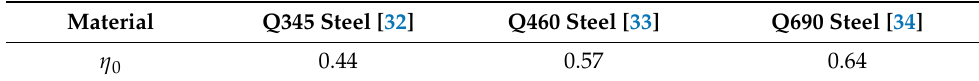
Table 1. Values of η 0 for some typical structural